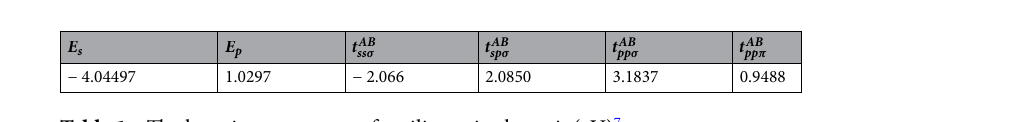
Table 1. The hopping parameters for silicene in the unit (eV) 7